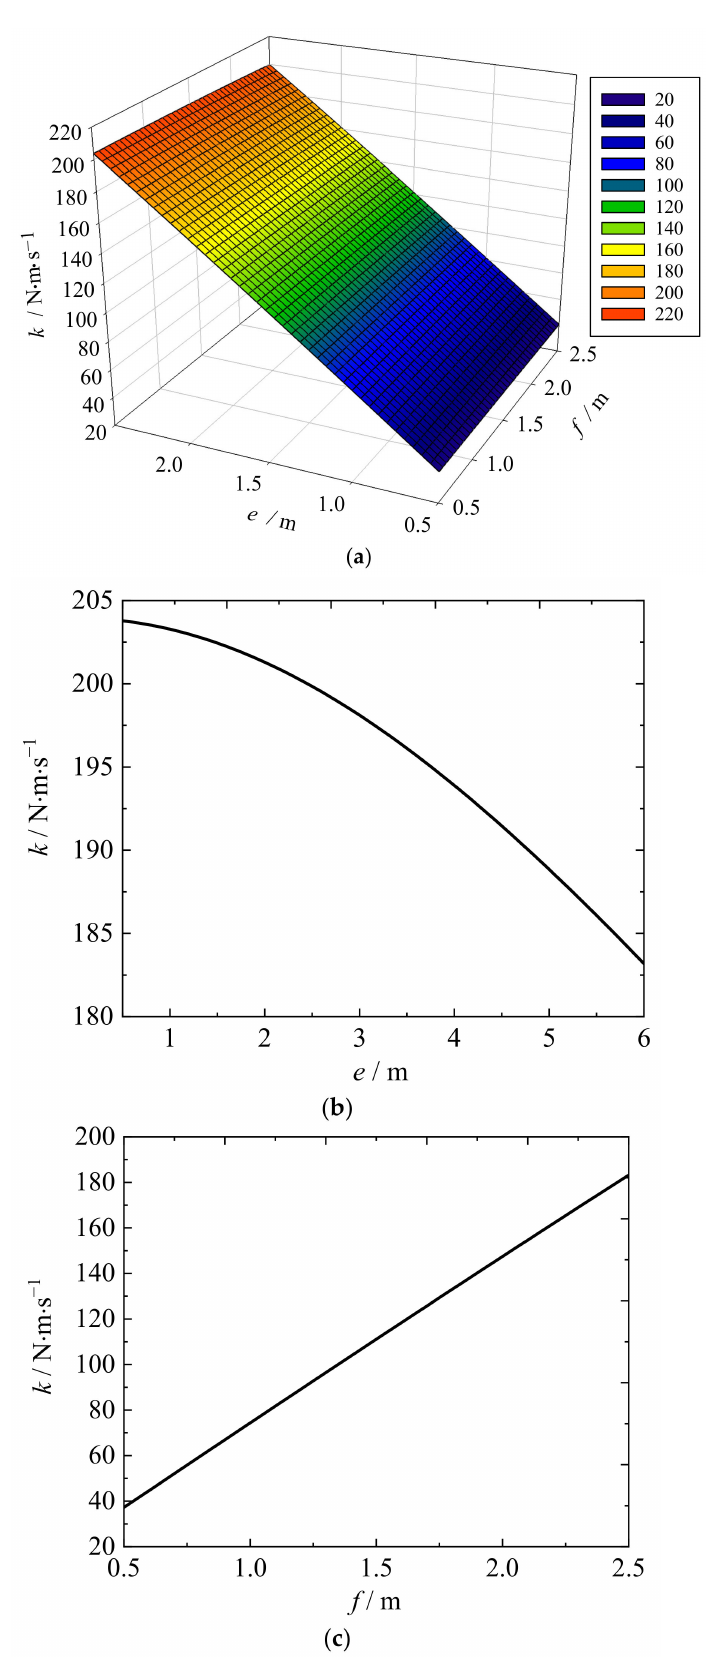
Figure 12. Effects of e and f on k . ( a ) The joint effect of e and f on k. ( b ) The influence of e on k ( f is constant). ( c ) The influence of f on k ( e is